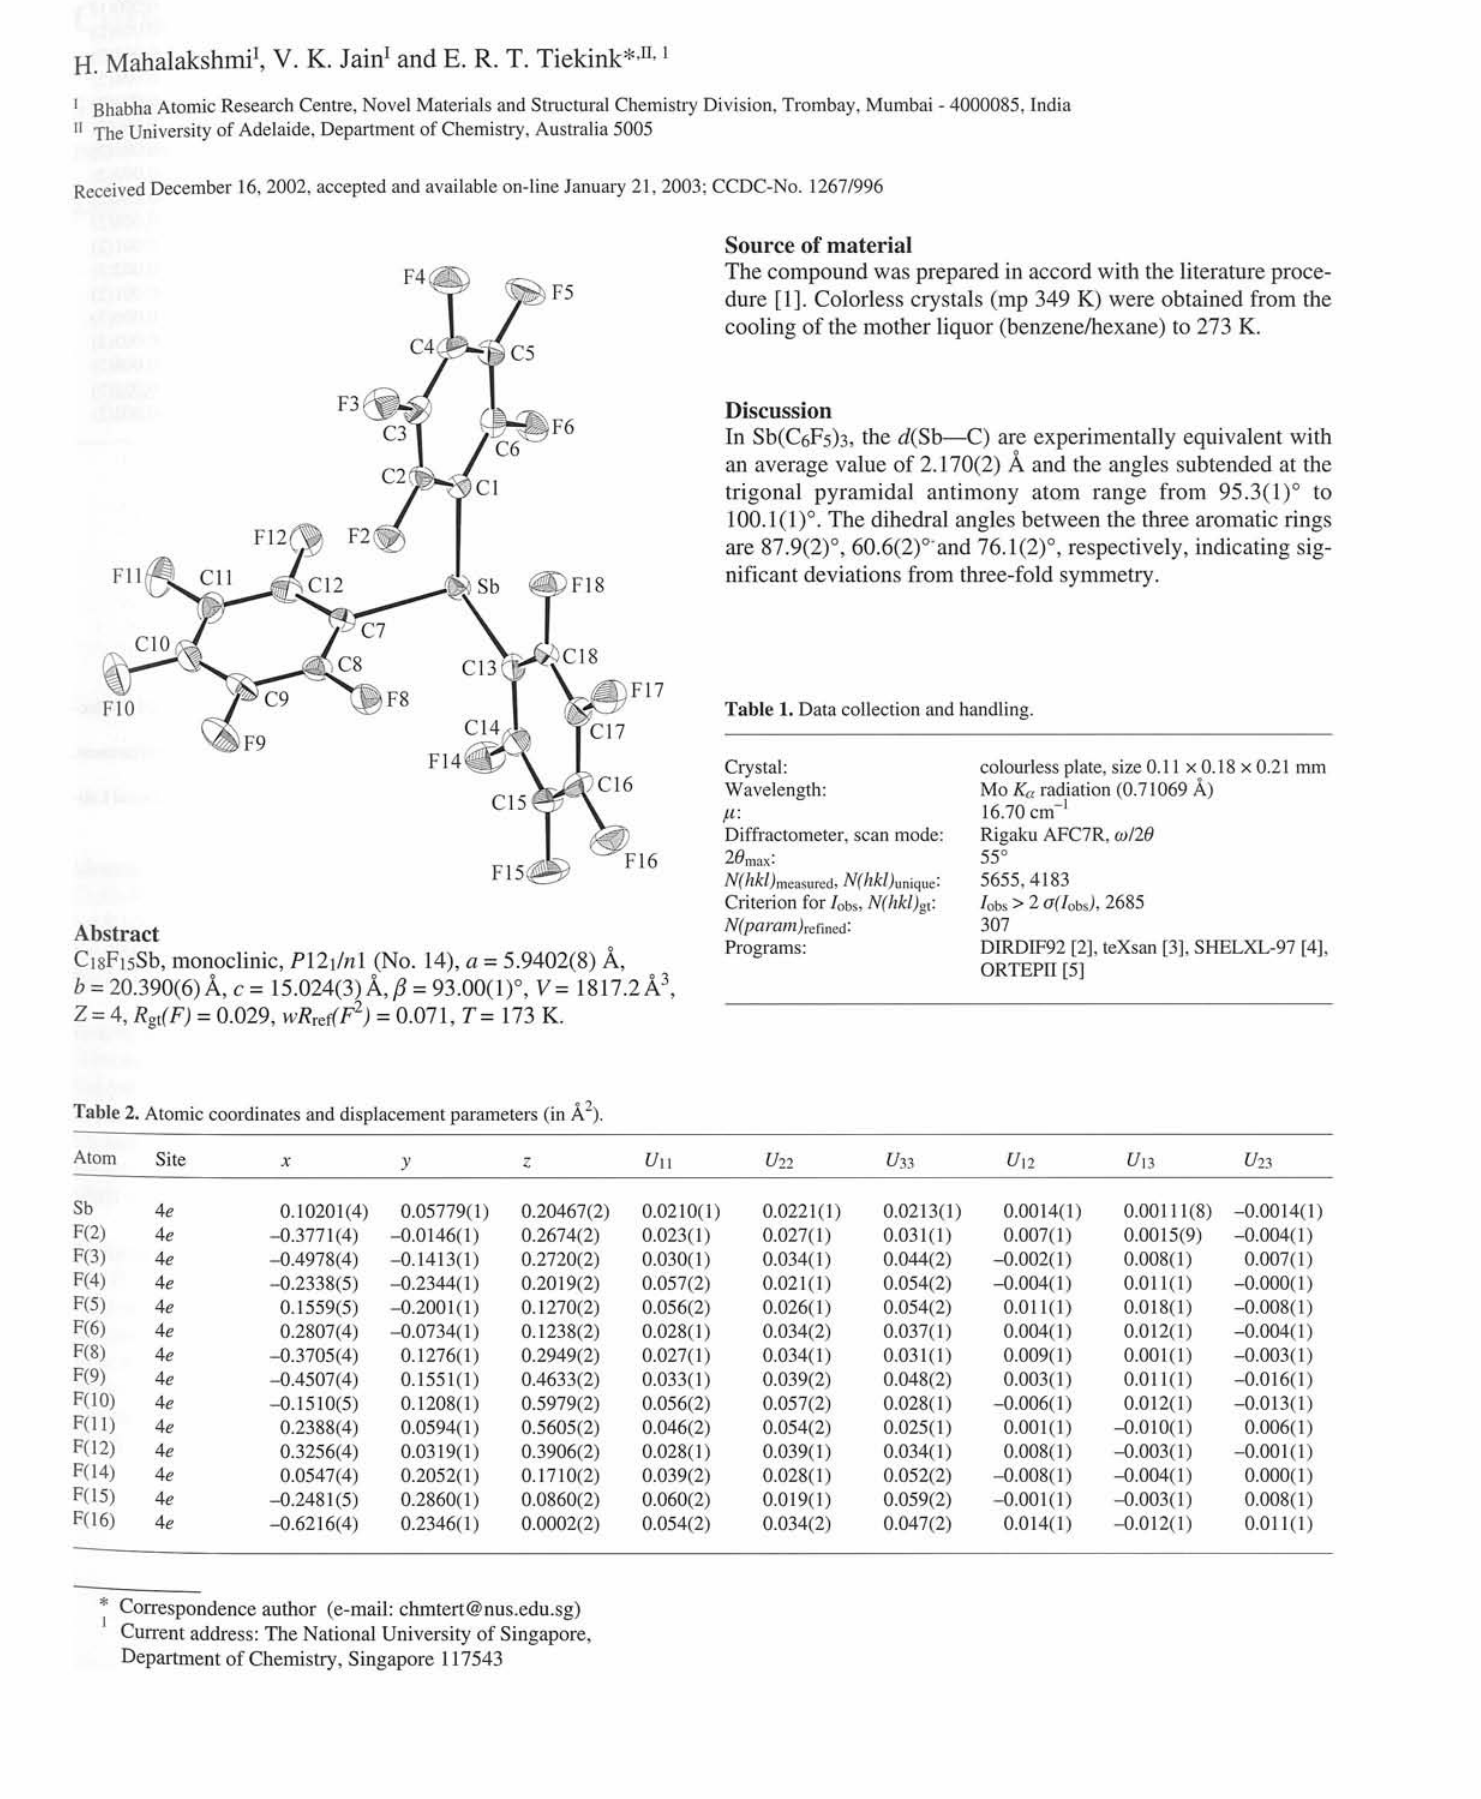
Table 1. Data collection and handling.